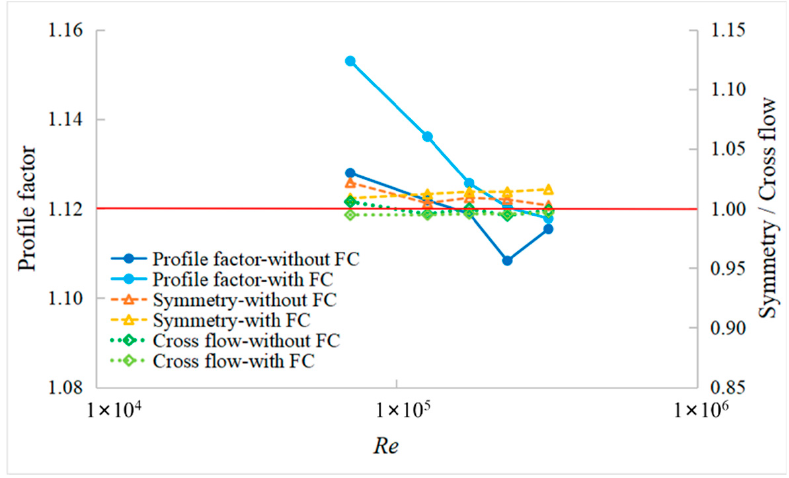
Figure 9. The difference between the parameters with different installation conditions.